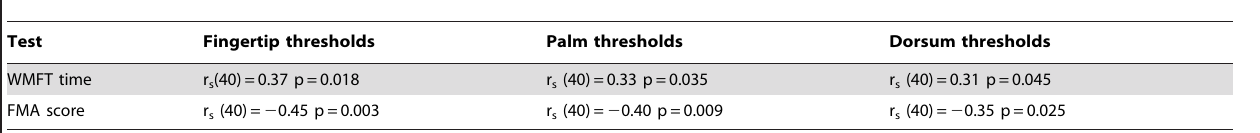
Table 2. Correlation between cutaneous thresholds and motor-function